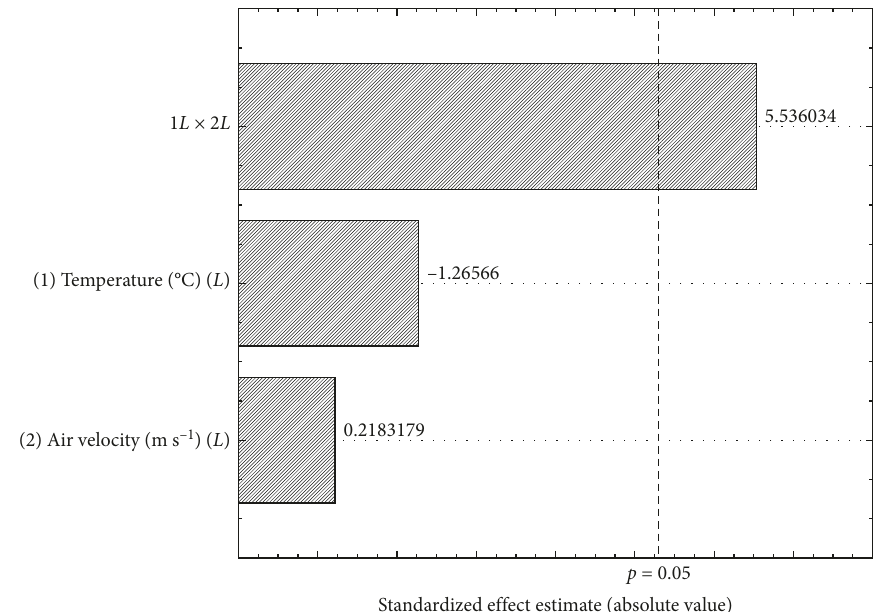
Figure 4: Pareto chart showing the effect of air temperature and velocity on the total phenolic compounds of the extracts.